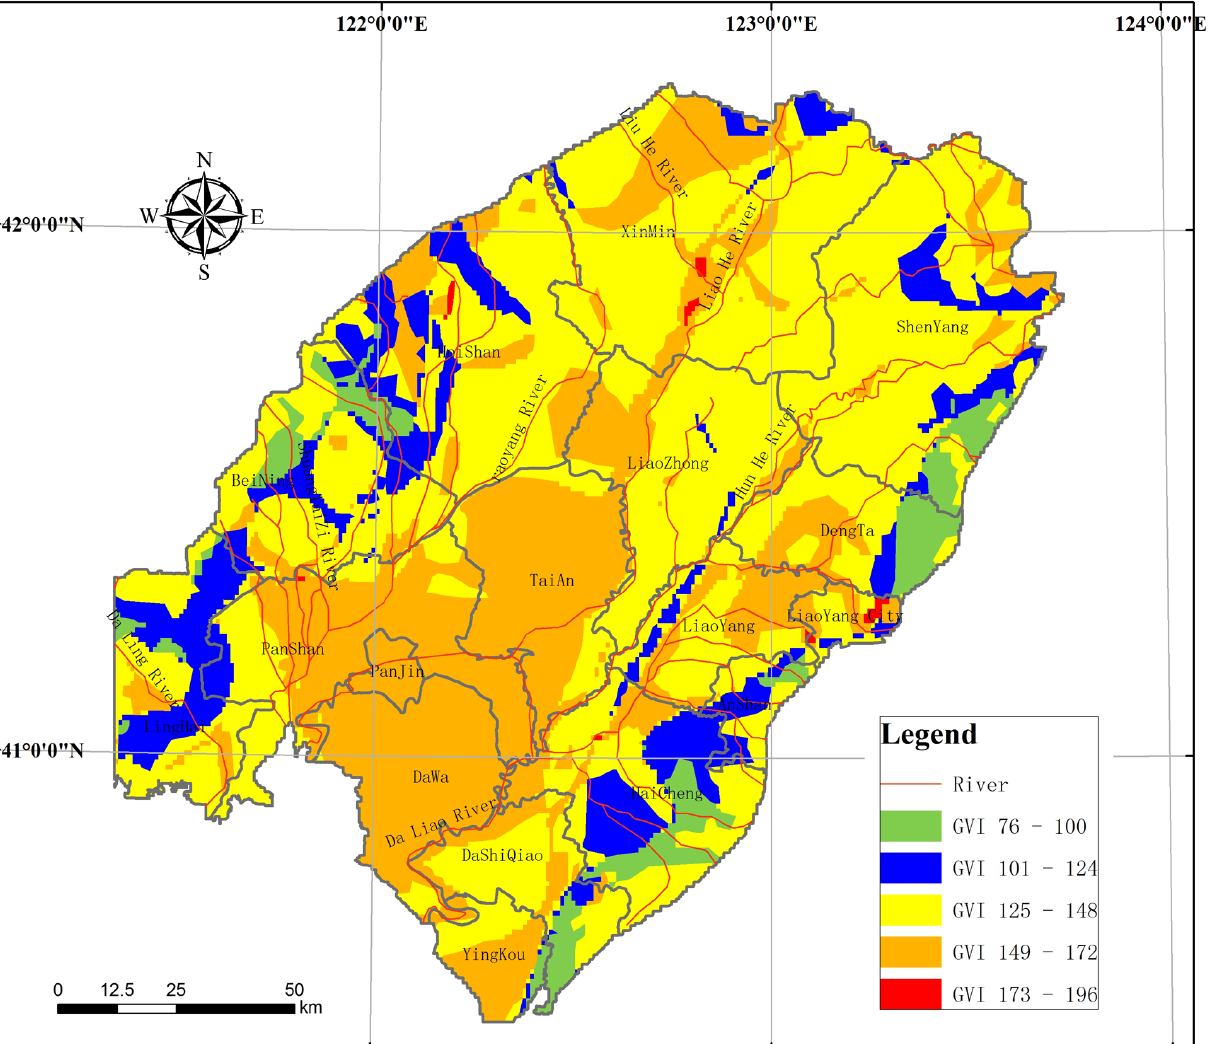
Fig 7. Groundwater vulnerability index(GVI) in the study